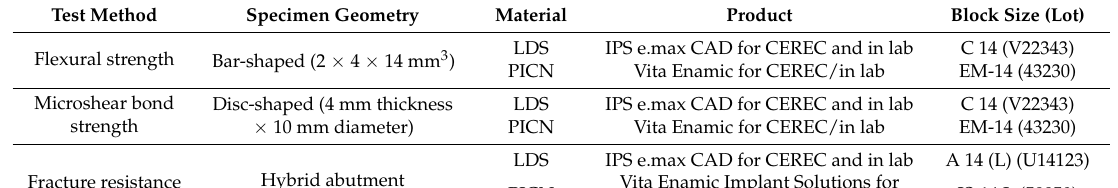
Table 1. Materials and specimen geometries used in this study.